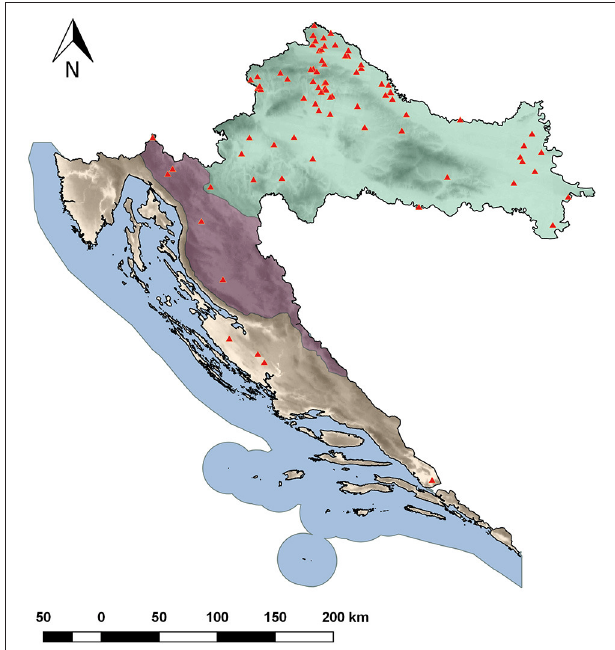
FIGURE 1 | Common bean sampling locations in